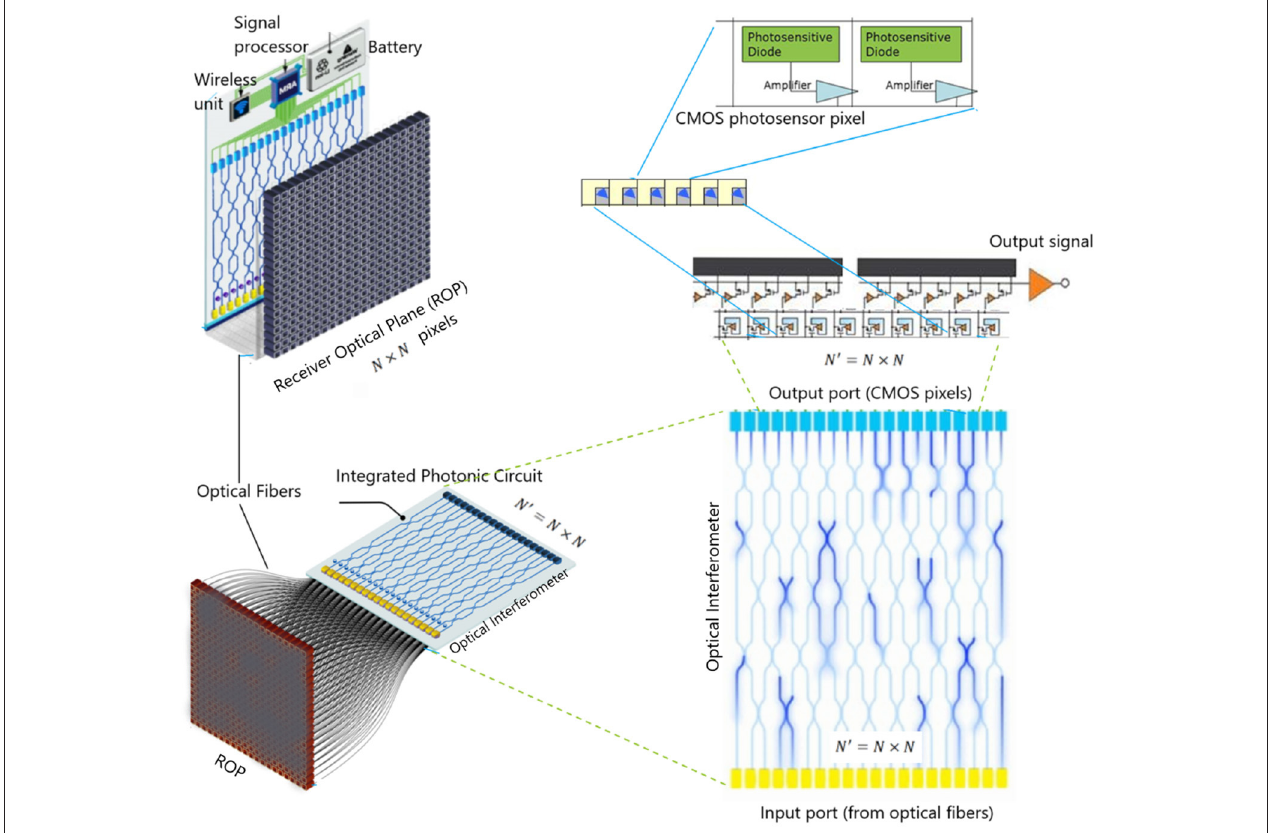
FIGURE 6 | A typical on-chip ultraweak photon emission (UPE) detector can be built from an array of optical fibers connected to an integrated photonic circuit, which has an output gate composed of complementary metal-oxide-semiconductor (CMOS) photosensor